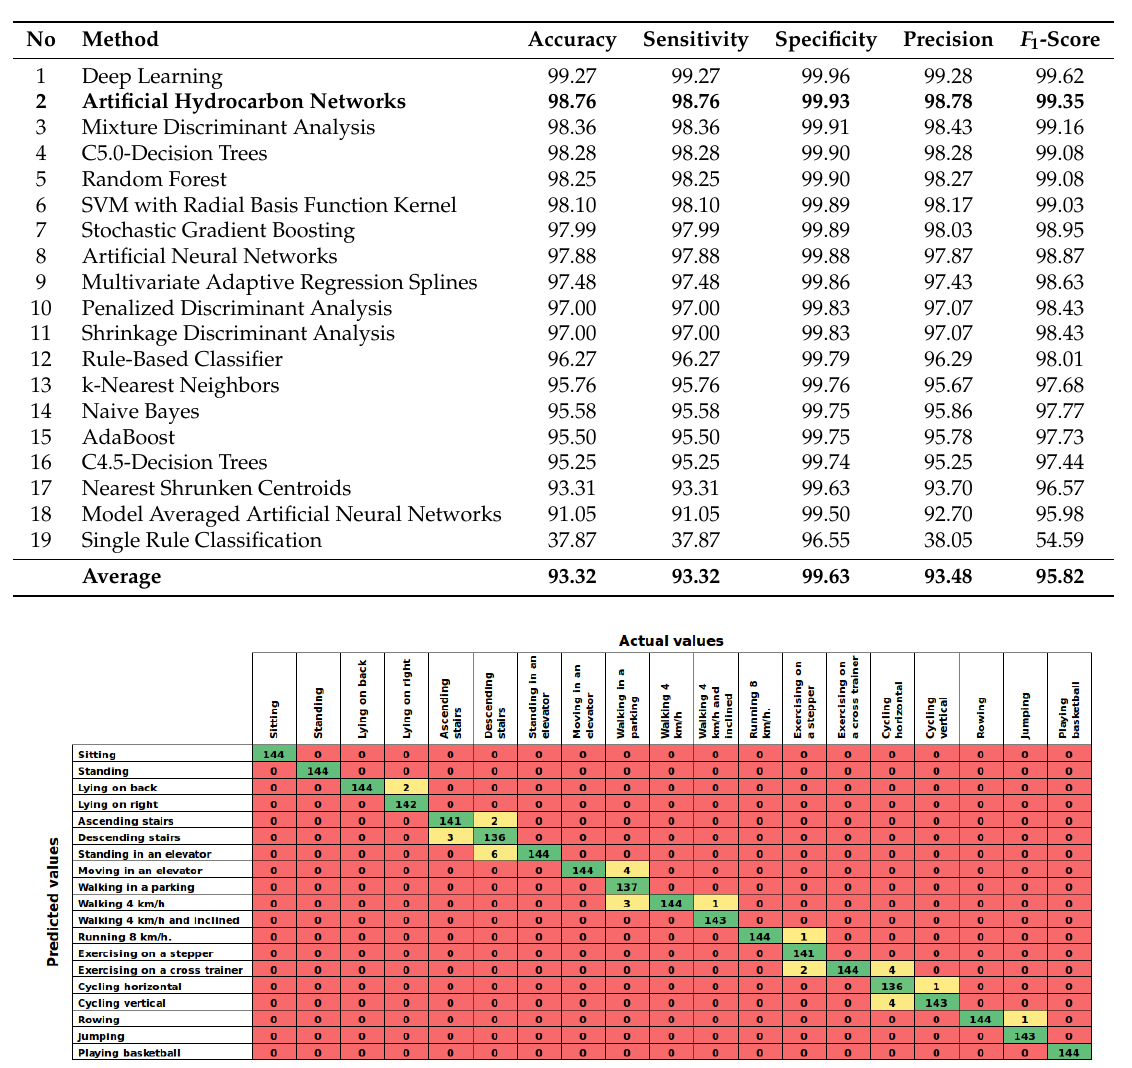
Table 6. Results of case 1: Performance for all subjects using cross-validation.